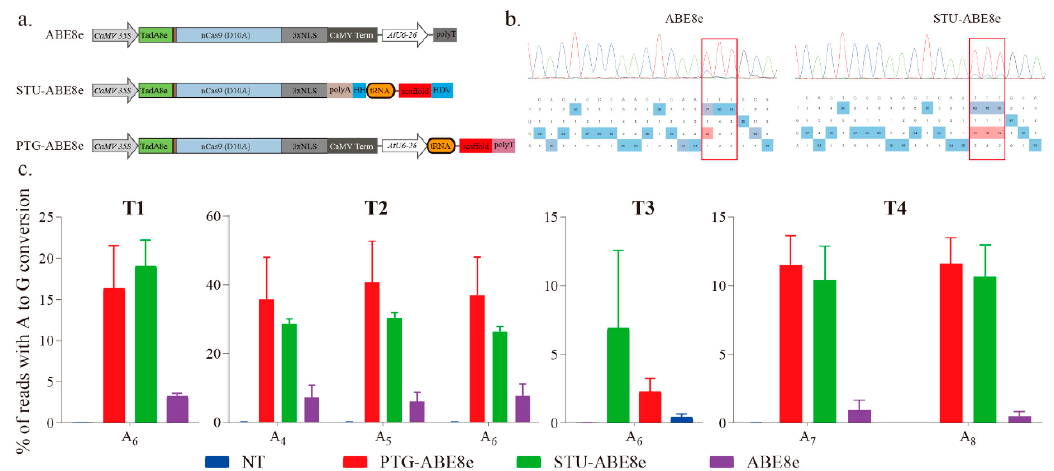
Figure 3. Estimating A-to-G base editing induced by ABE8e variants harboring different sgRNA expression cassettes in N. benthamiana . ( a ) Schematic depicting ABE8e variants structure. NLS, nuclear localization sequence; HH, hammerhead ribozyme; HDV, hepatitis delta virus ribozyme. ( b ) Sanger sequencing chromatograms of the T2 target for ABE8e variants. The sequencing chromatograms show the results sequenced from the reverse direction. Red squares indicate the edited bases induced by ABE8e variants. ( c ) Frequencies of A-to-G conversions induced by ABE8e variants at four target sites based on amplicon deep sequencing results. Frequencies (mean ± SEM) were calculated from three independent experiments ( n = 3). NT, no-treatment.